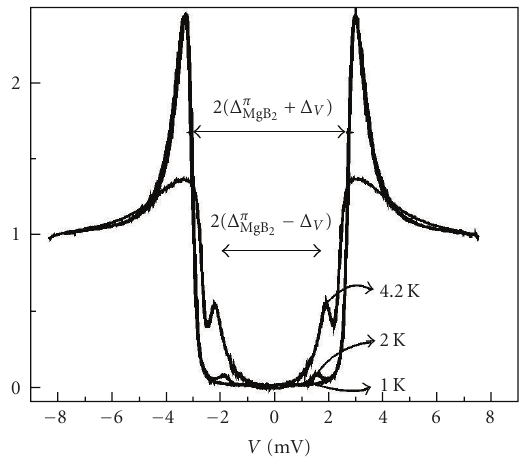
Figure 5: (From [26]) Normalized di ff erential conductance of a MgB 2 /Al 2 O 3 /V tunnel junction, showing evidence for sum and di ff erence gaps of the two superconductors. c of